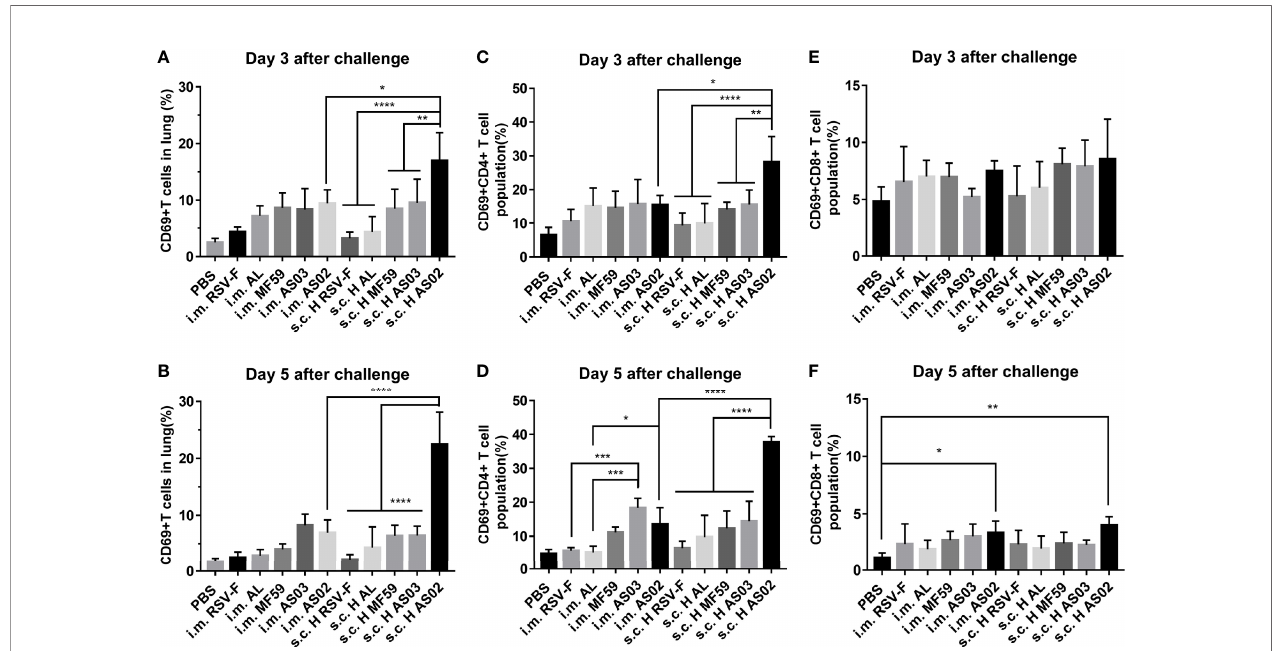
FIGURE 8 | Activated T cells and their subsets in the lungs of immunized mice after challenge. On day 3 or 5 post-challenge, mice (n= 4 or 5) from different groups were euthanized and lungs were removed to analyze the expression levels of active T cells (A, B) , Th cells (C, D) , and Tc cells (E, F) through the expression of CD69 by fl ow cytometry. Data were analyzed with two-way ANOVA with Tukey ’ s multiple comparisons test. *P< 0.05, **P <0.01, ***P< 0.001,